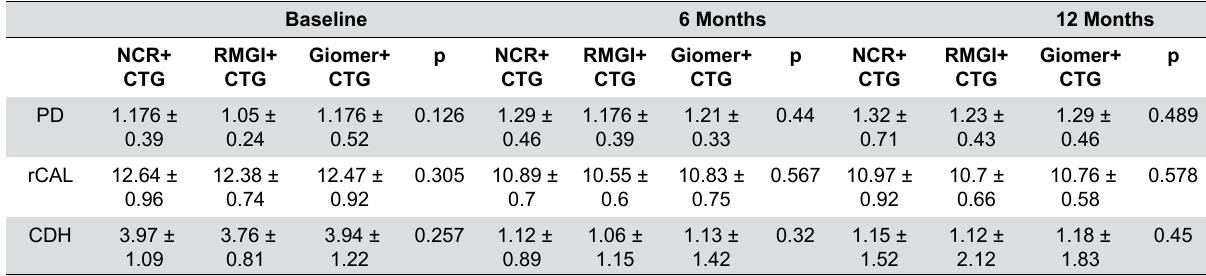
Table 1- Clinical parameters of the treatment groups in the study follow-up periods